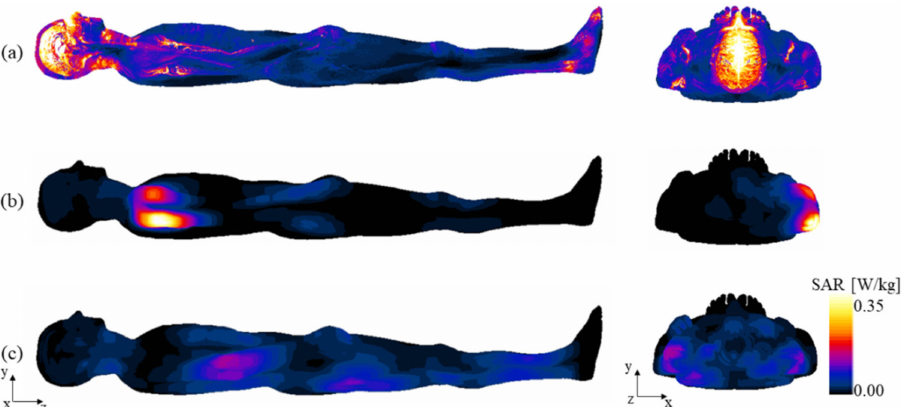
Figure 9. The computed projected maximum SAR maps in sagittal and axial views, for ( a ) the path antenna, ( b ) birdcage coil, and ( c ) the array of triple-line microstrips. Table 1 summarizes the mean and standard deviation of each |B 1+ |-field in Figure 7 and Figure 8, and the SAR maps in Figure 9. Table 1. Mean and standard deviation of |B 1+ | field. Mean/CV |B1+| Mean/Max RF